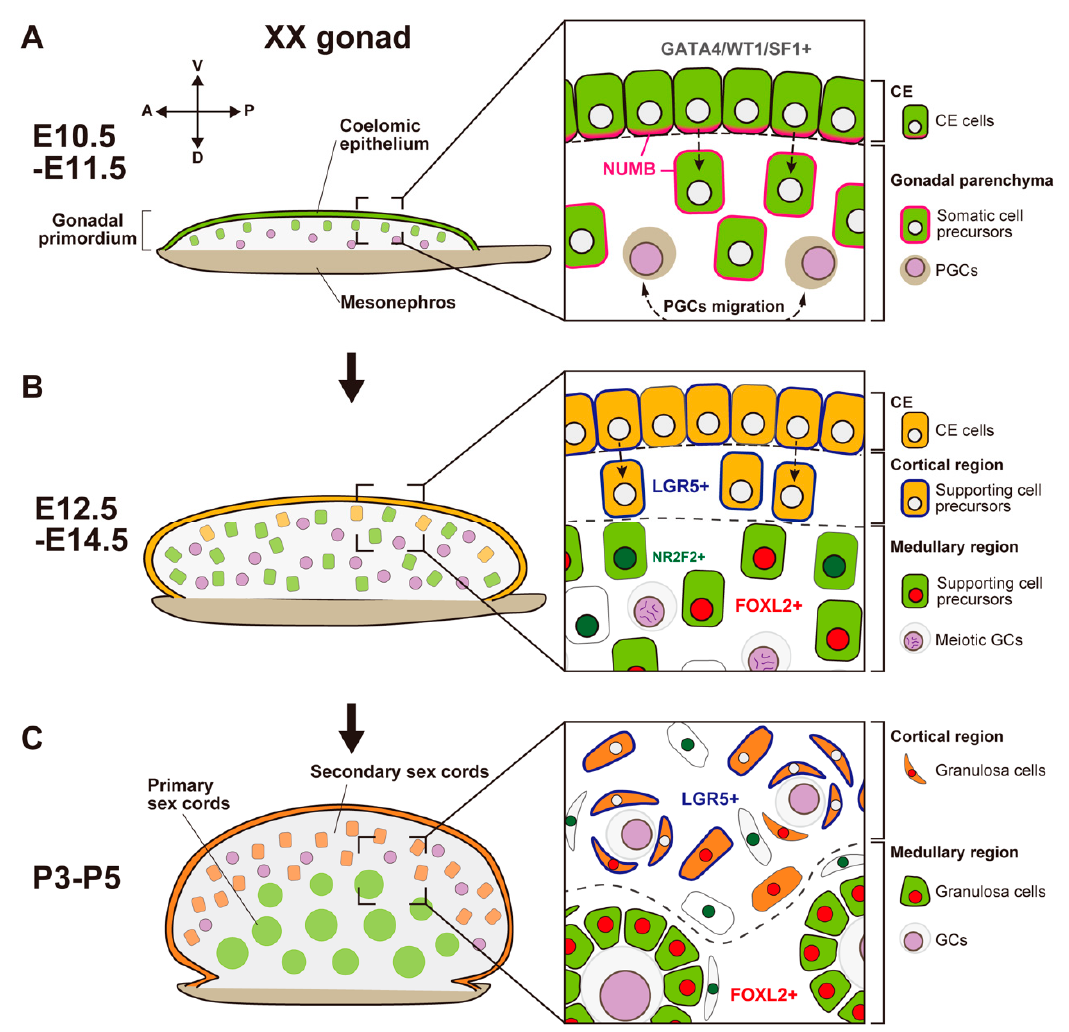
Figure 2. Schematic representation showing morphological changes and somatic cell differentiation along the cortical-medullary axis during fetal and postnatal stages, from the bipotential gonadal primordium at E10.5 to the differentiated ovary around P5. ( A ) At E10.5, the CE cells proliferate and ingress into the gonadal parenchyma, controlled by the NUMB distribution (magenta) and Notch signaling, to form primary sex cords without sexual dimorphism. ( B ) At E12.5, supporting cell precursors in the medullary region (green cells) express an early ovarian factor, FOXL2 (red). In contrast to testis differentiation, the proliferation and ingression of the CE in XX gonads continues after E12.5, leading to the formation of secondary sex cords in the cortical region (orange cells). Supporting cell precursors in secondary sex cords, including CE cells, express the transmembrane receptor LGR5 (blue). LGR5 and FOXL2 expression is mutually exclusive, and it exhibits a gradient from the cortex (CE side) to the medulla (mesonephric side). Other somatic cells (i.e., interstitial precursor cells) also exclusively express NR2F2 (deep green). Germ cells (GCs) initiate meiosis at E12.5 (deep purple, condensed chromosomes). ( C ) At postnatal stages, FOXL2-positive granulosa cells in primary sex cords in the medullary region contribute to the formation of the first wave of follicles. In the cortical region, granulosa cells that originate from LGR5-positive cells (orange cells) form the secondary sex cords and primordial follicle pools. After sexual maturity, these follicles develop according to the estrous